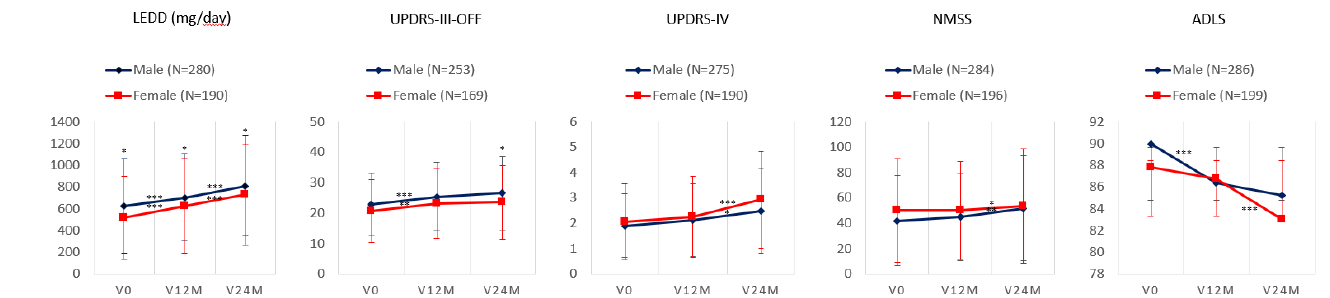
Figure 3. Mean and standard deviation at V0, V12M, and V24M in males vs. females in the LEDD (mg/day) and the score on UPDRS-III-OFF, UPDRS-IV, NMSS, and ADLS; *, p < 0.05; **, p < 0.001; ***, p < 0.0001. The symbol above the line represents the significance of the change between one visit and another (in men and women) while the symbol above the point/diamond represents the difference in that visit between men and women. ADLS, Schwab and England Activities of Daily Living Scale; LEDD, levodopa equivalent daily dose; NMSS, Non-Motor Symptoms Scale; UPDRS, Unified Parkinson´s Disease Rating Scale.